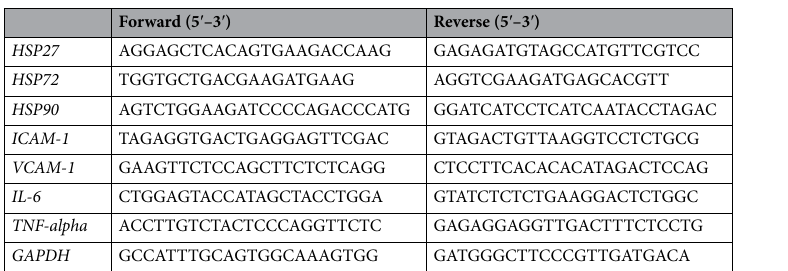
Figure 6. Effect of the induction of heat shock proteins (HSP) on the expression of inflammatory cytokines in the aorta in ApoE −/− mice. ( A ) Interleukin 6 ( IL-6 ) and tumor necrosis factor-alpha ( TNF-alpha ) mRNA expression levels in the aorta after geranylgeranylacetone (GGA) administration. 10-week-old ApoE −/− mice, evidencing the formation of atheromas, were administered vehicle or GGA (500 mg/kg/day) for 24 h. Then, total RNA was extracted from the aorta. ( B ) IL-6 and TNF-alpha mRNA expression levels in the aorta after heat shock treatment. 10-week-old ApoE −/− mice, demonstrating the formation of atheromas, were treated in a 30 °C (control) or 41 °C (heat shock) warm bath for 30 min. After 24 h, total RNA was extracted from the aorta. Each bar represents the mean ± standard deviation (SD). Significant differences are marked on the chart (*p < 0.05; **p < 0.01). n = 5–8 mice per group. Forward (5 ′ –3 ′